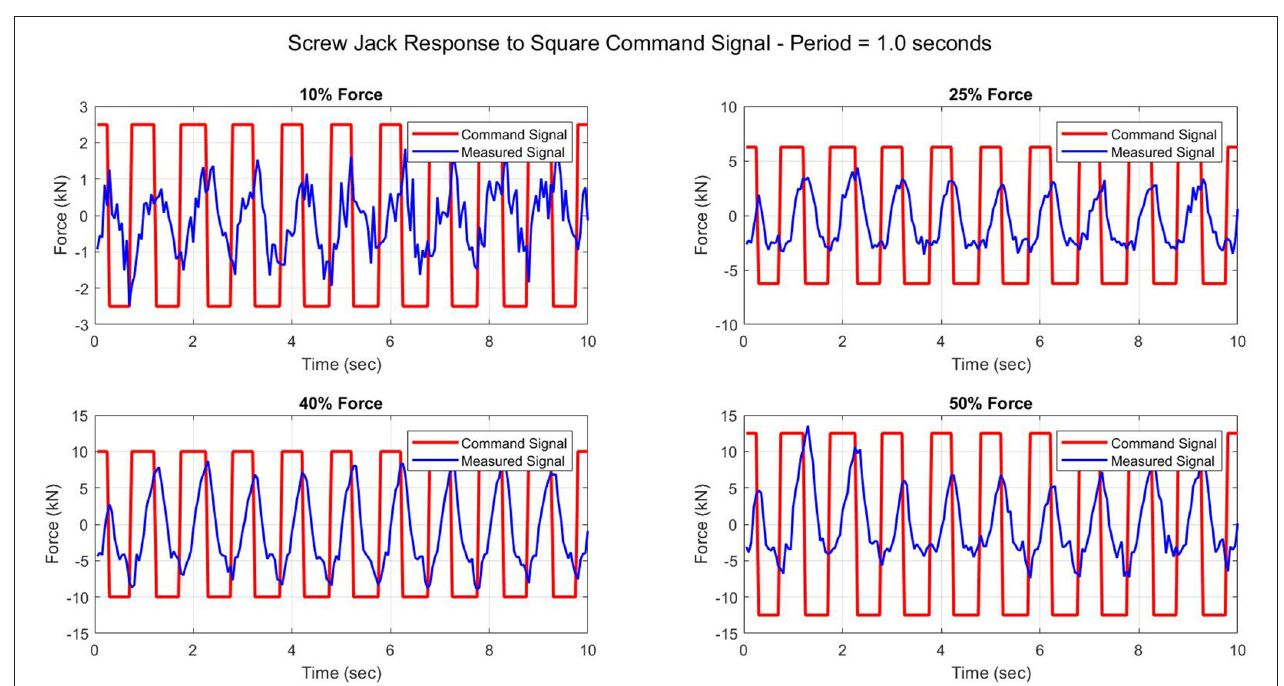
FIGURE 5 | Screw jack characterization tests: square wave force command, period = 1.0s.